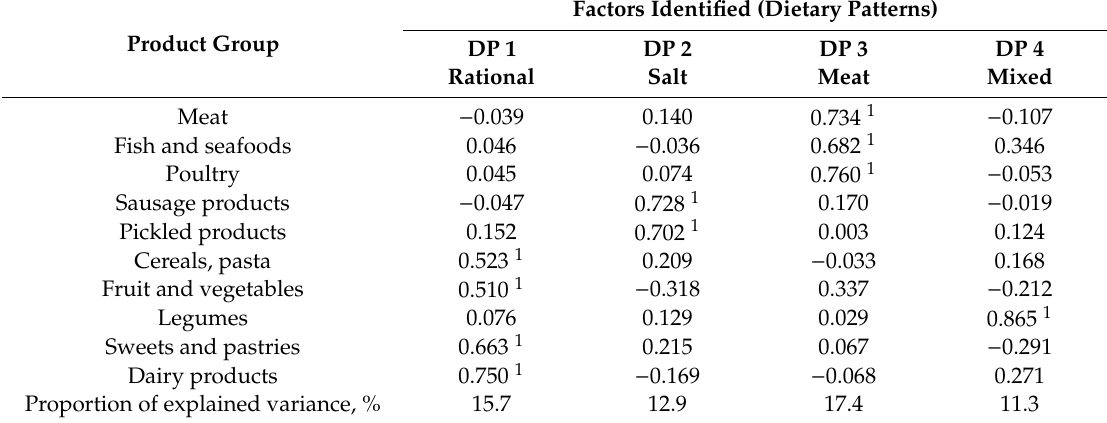
Table A19. Factor loadings of the principal dietary patterns identified (Republic of North